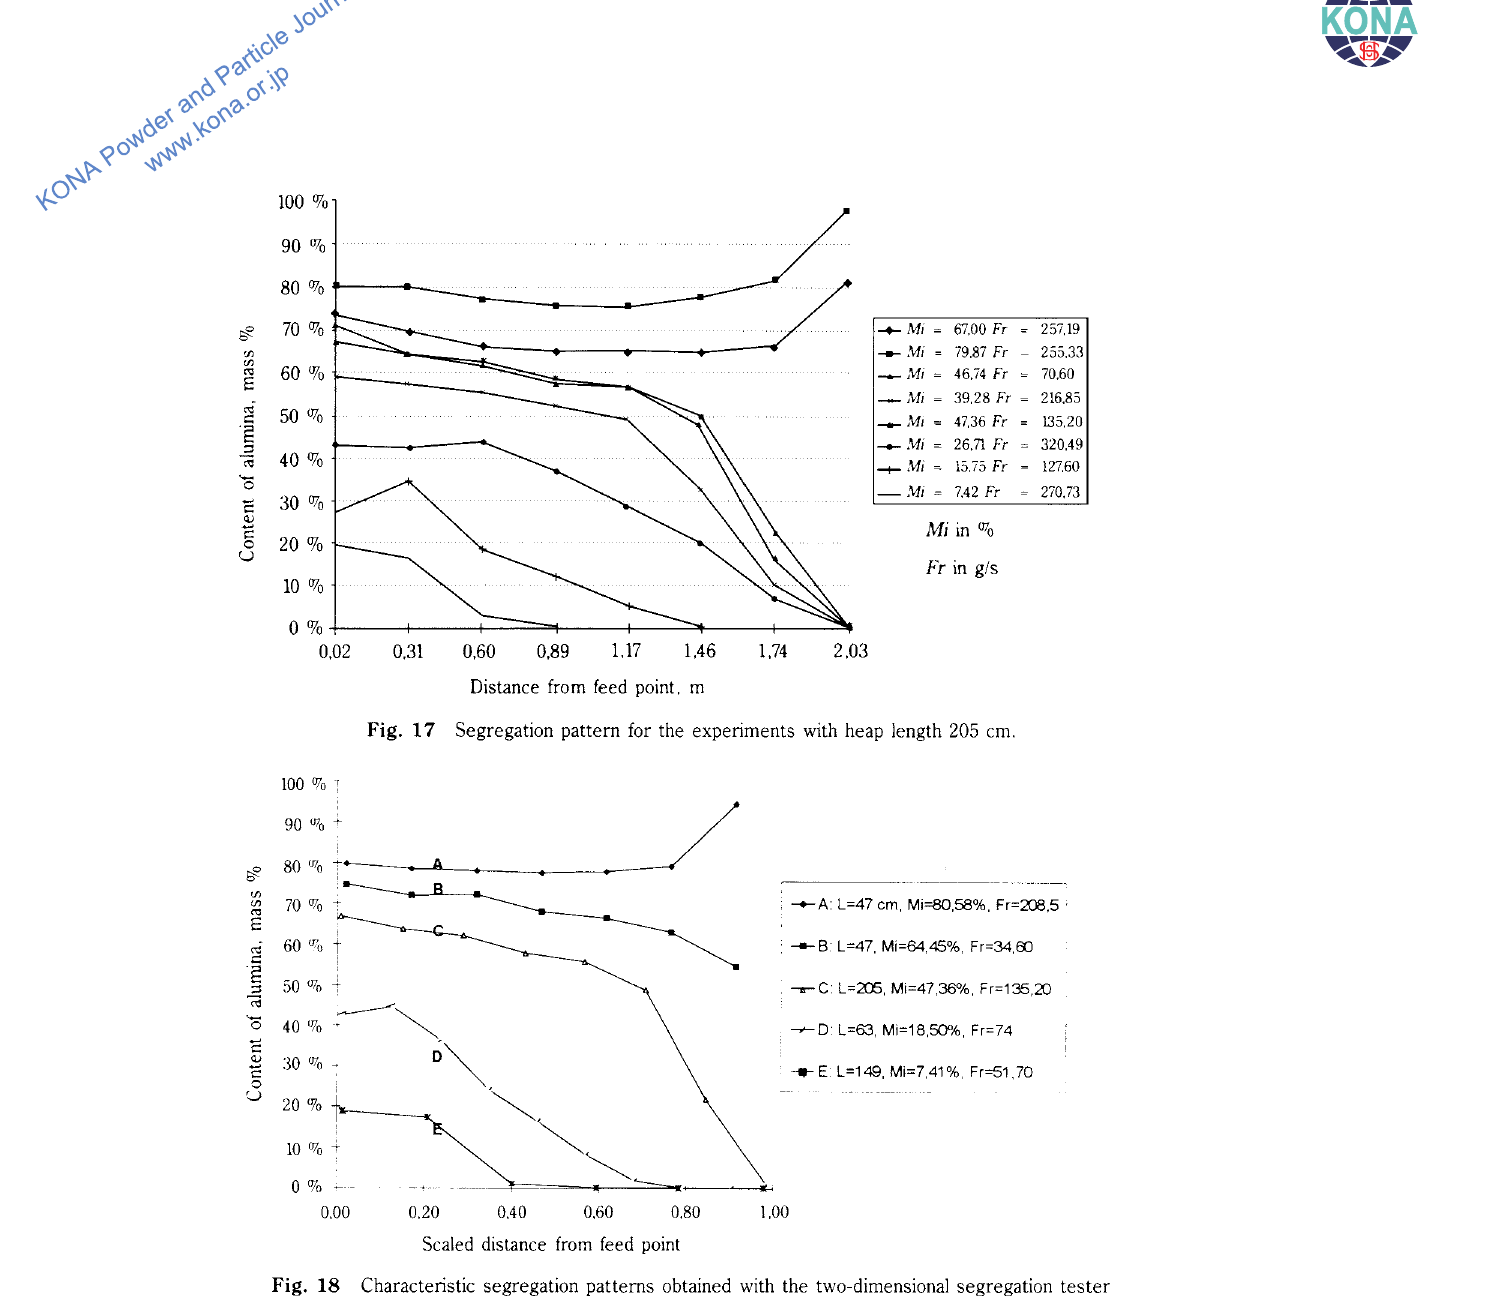
Fig. 18 Characteristic segregation patterns obtained with the two-dimensional segregation